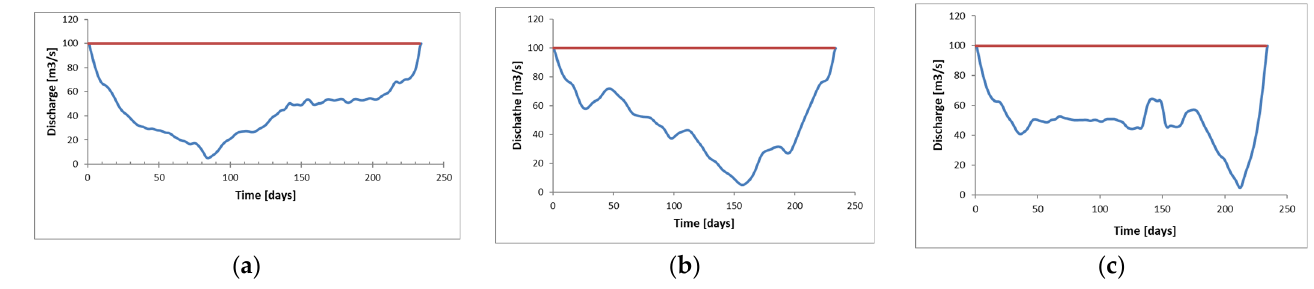
Figure 2. Examples of drought shapes: ( a ) shape 1; ( b ) shape 2; ( c ) shape 3.